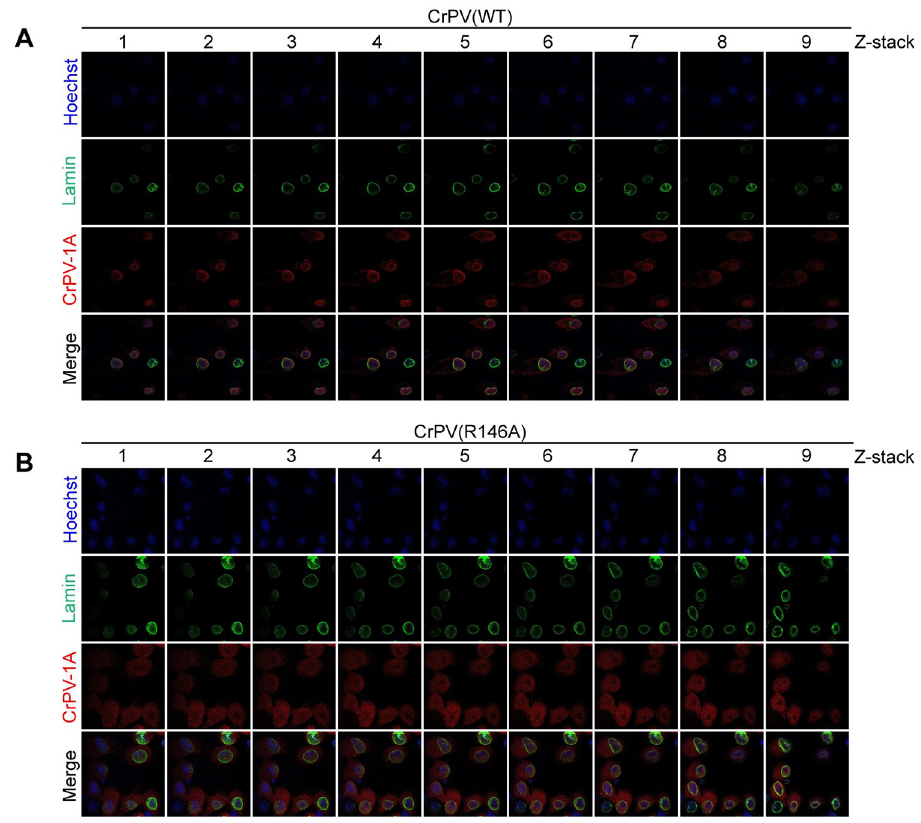
Fig 5. CrPV-1A localizes to the nucleus during virus infection. Z-stack confocal images of S2 cells infected with (A) wild-type CrPV or (B) CrPV(R146A) virus. From left to right are Z-stack images through the cells. Cells were fixed and stained with Lamin (green), CrPV-1A (red) and Hoechst (blue). Shown are representative images from three independent